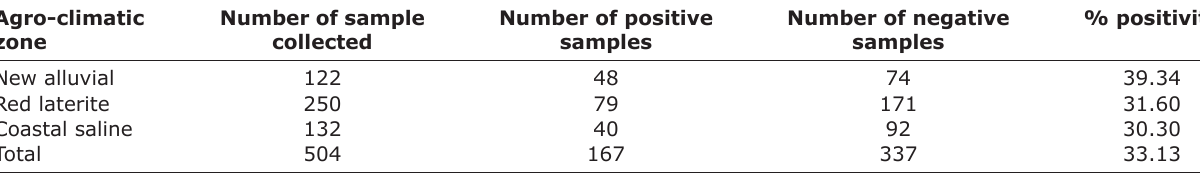
Table-2: Assessment of sheep serum samples by i-ELISA to detect anti-bluetongue